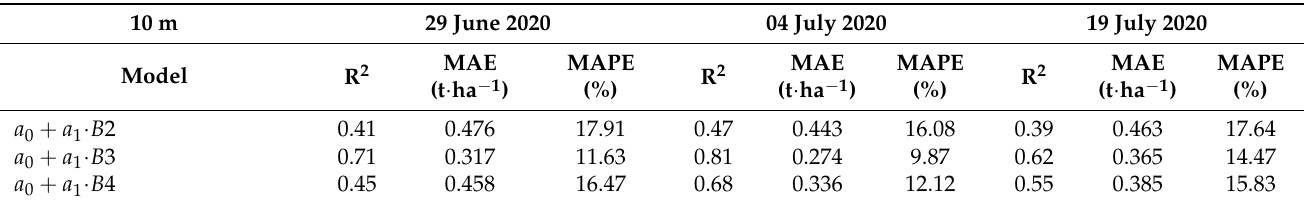
Table A3. Bomba 10 m spatial resolution model evaluation with training data (model coefficients are different for each